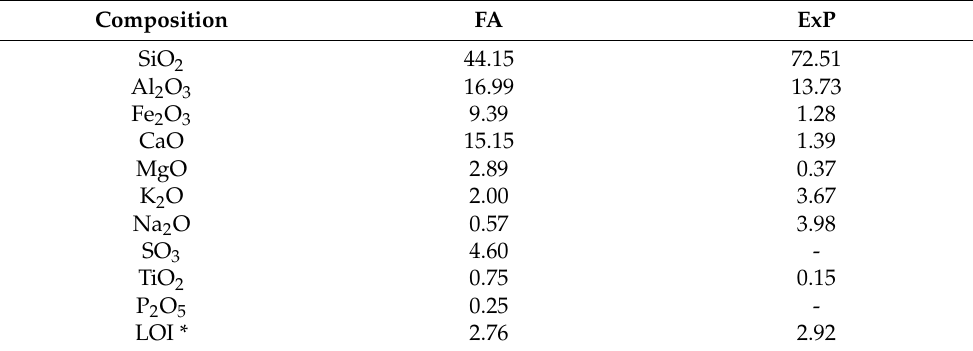
Figure 1. Particle size distributions of FA ( a ) and ExP ( b ). Table 1. Chemical composition of FA and ExP (% wt.).